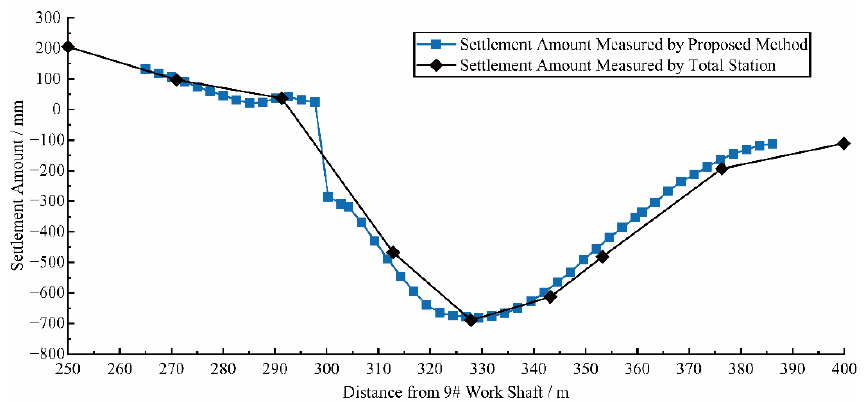
Figure 8. Comparison of experimental results of vertical LDC.